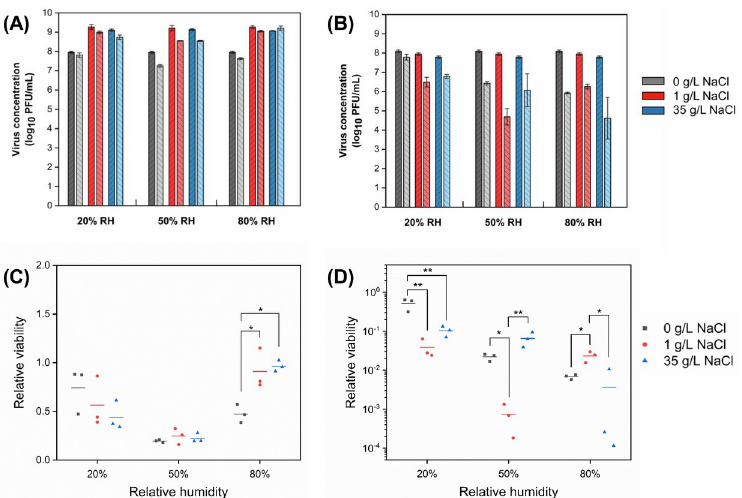
Fig 2. Concentration of bacteriophages (A) MS2 and (B) F 6 in droplets with different initial sodium chloride concentration before (dark bars) and after (light bars) 1 h exposure to low, intermediate, and high RH (mean ± s.d. of triplicates). Relative viability of (C) MS2 and (D) F 6 after 1 h exposure (lines shown the mean of triplicates). The number of virions in droplets at the start of the exposure experiments was 10 5 − 10 6 PFU.